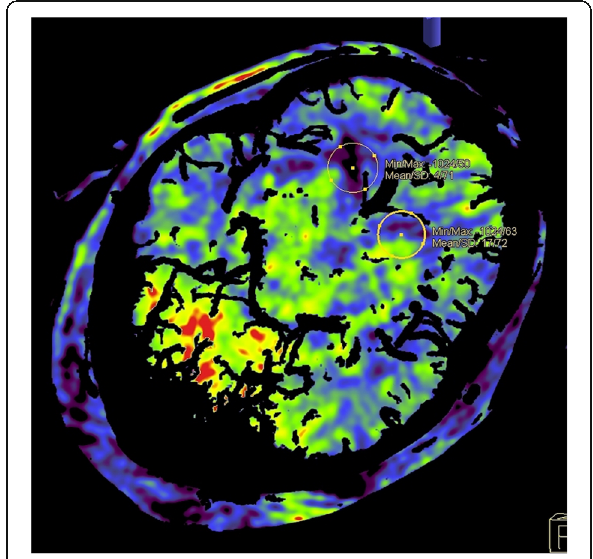
Fig. 7 MRI cerebral angiography showed MCA occlusion and a good graft blood supply. Frontal